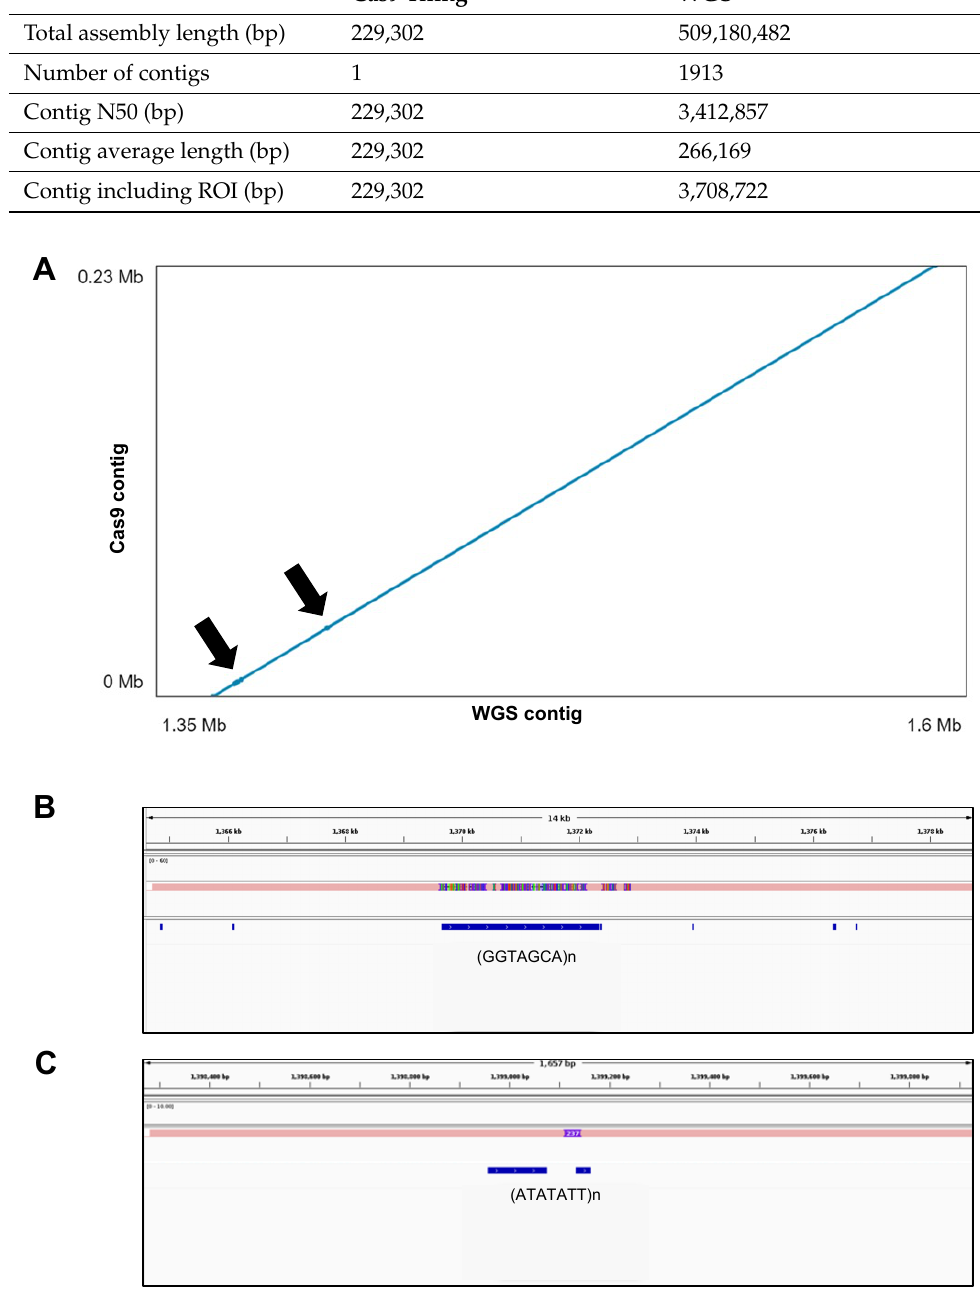
Figure 5. Comparison of de novo assemblies from Cas9 tiling and nanopore WGS data in the pod- shattering region. ( A ) Dot plot viewer of contig–contig alignment showing the nanopore WGS assembly on the x -axis and the Cas9 assembly on the y -axis. Divergent regions are highlighted with arrows. ( B , C ) Integrative Genome Viewer (IGV) visualization of the aligned Cas9-derived and nanopore WGS-derived contigs at the divergent regions. Blue boxes indicate repetitive regions annotated by